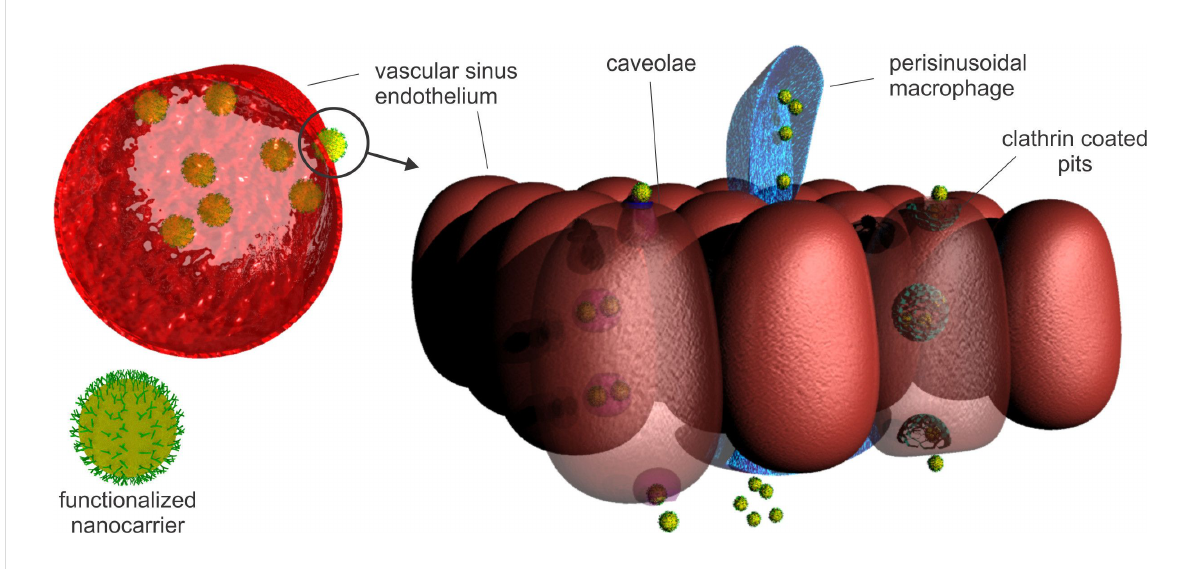
Figure 1: Hypothetical mechanisms of extravasation of NDDSs into the BM stroma. The nanoscale carrier could induce clathrin- or caveolin-medi- ated endocytosis into the vascular sinus endothelium, resulting in transcytosis towards the BM stroma. Another possible mechanism of extravasation of NDDSs is the uptake mediated through perisinusoidal